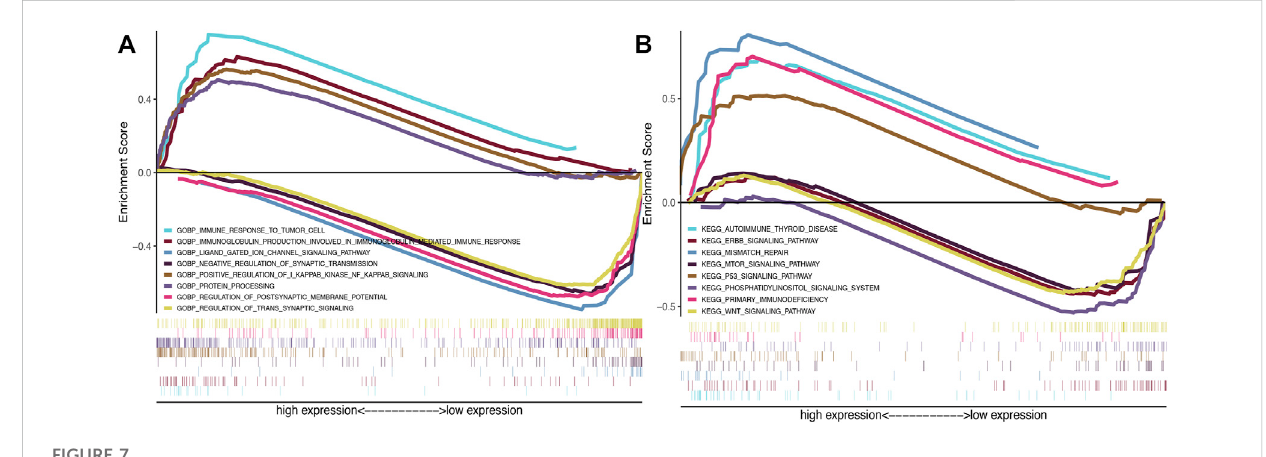
FIGURE 7 (A) Gene Ontology (GO) and (B) KEGG analyses of the 6 SRlncRNAs by